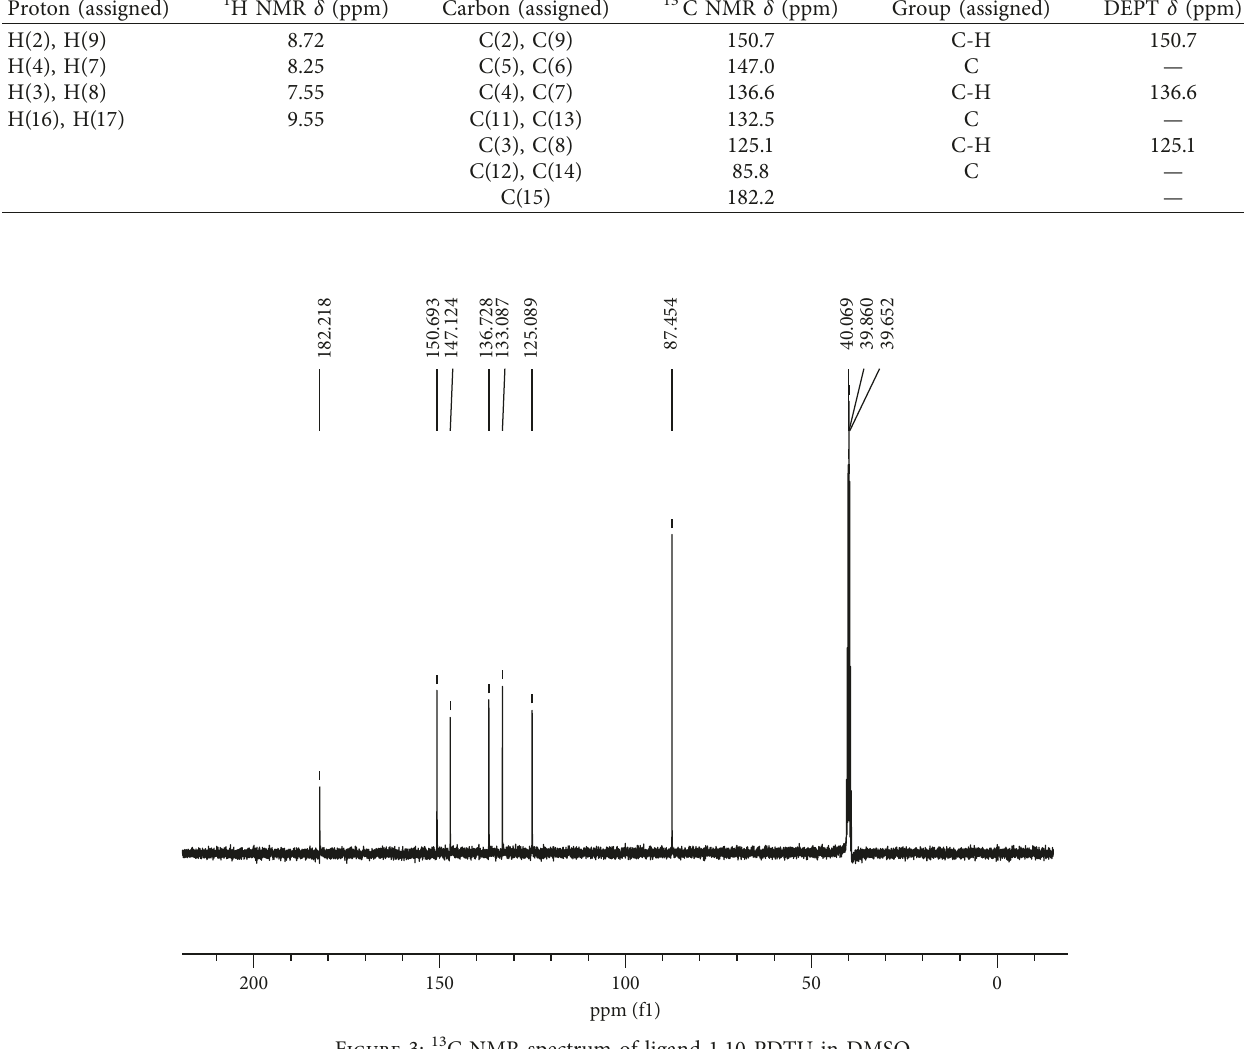
Figure 3: 13 C NMR spectrum of ligand 1,10-PDTU in DMSO. Table 3: Major IR spectral frequencies of the ligand and its